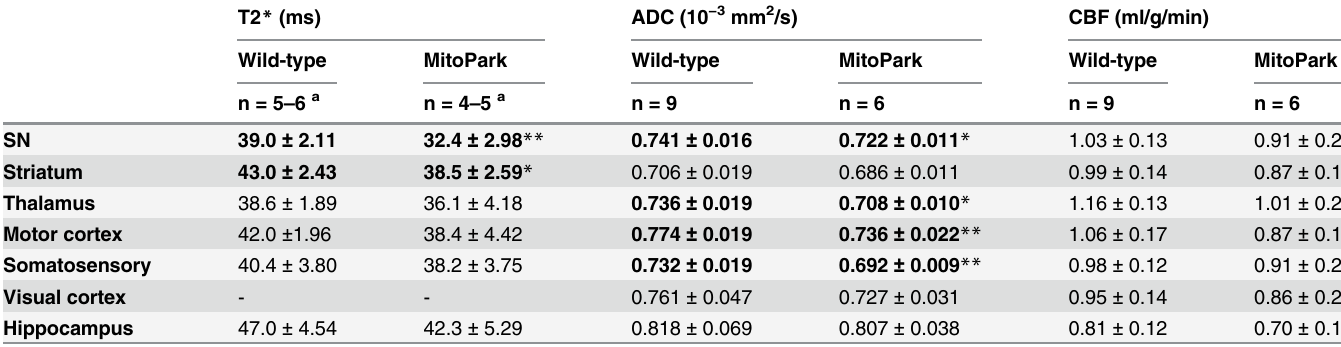
Table 1. T2 * , apparent diffusion coefficient (ADC), and cerebral blood flow (CBF) of the wild-type and MitoPark